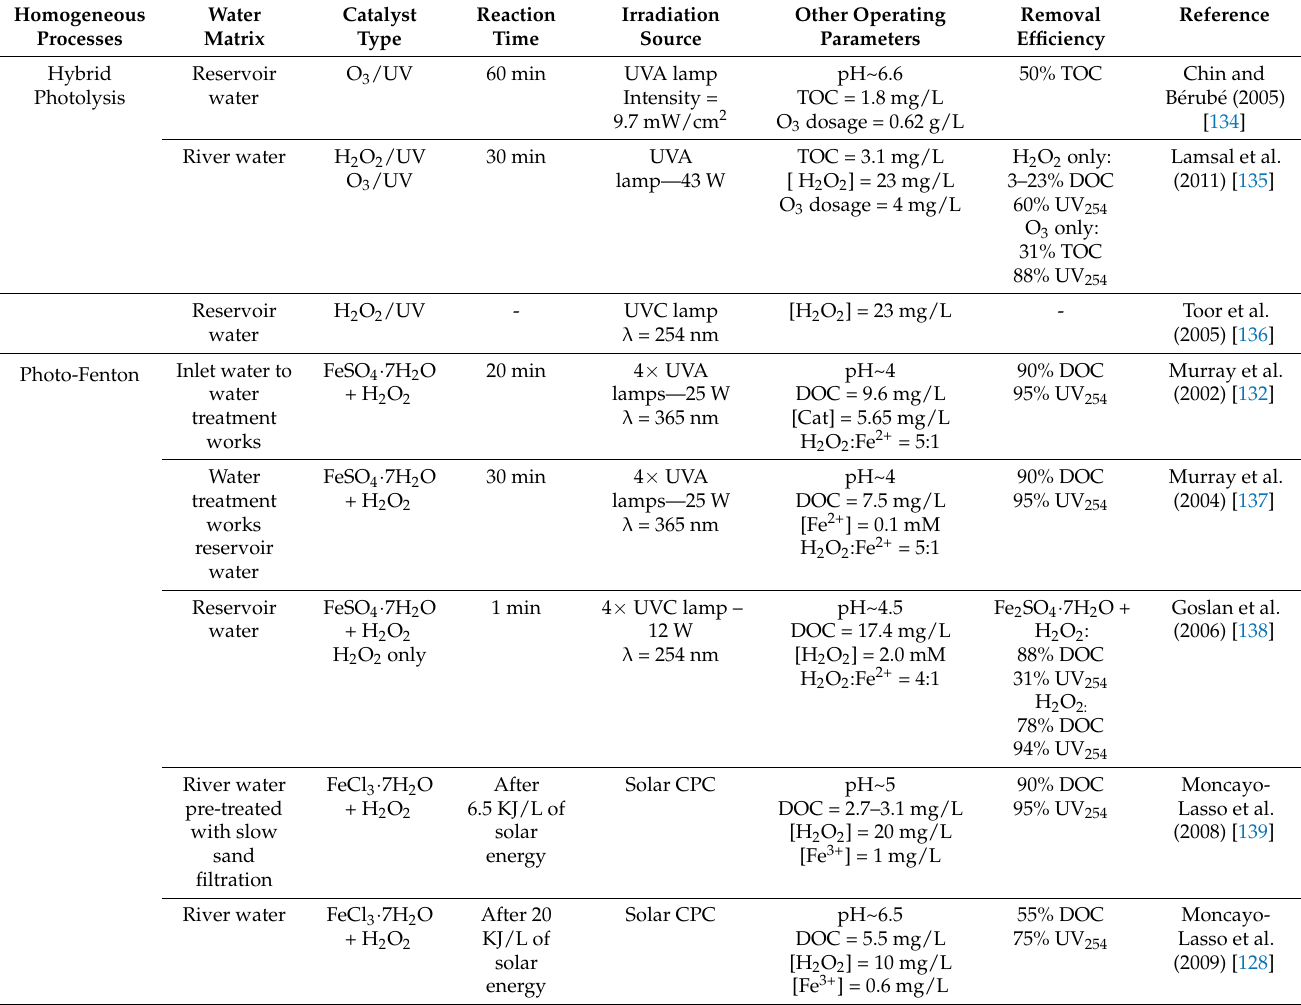
Table 3. Publications on homogeneous photocatalytic treatment of